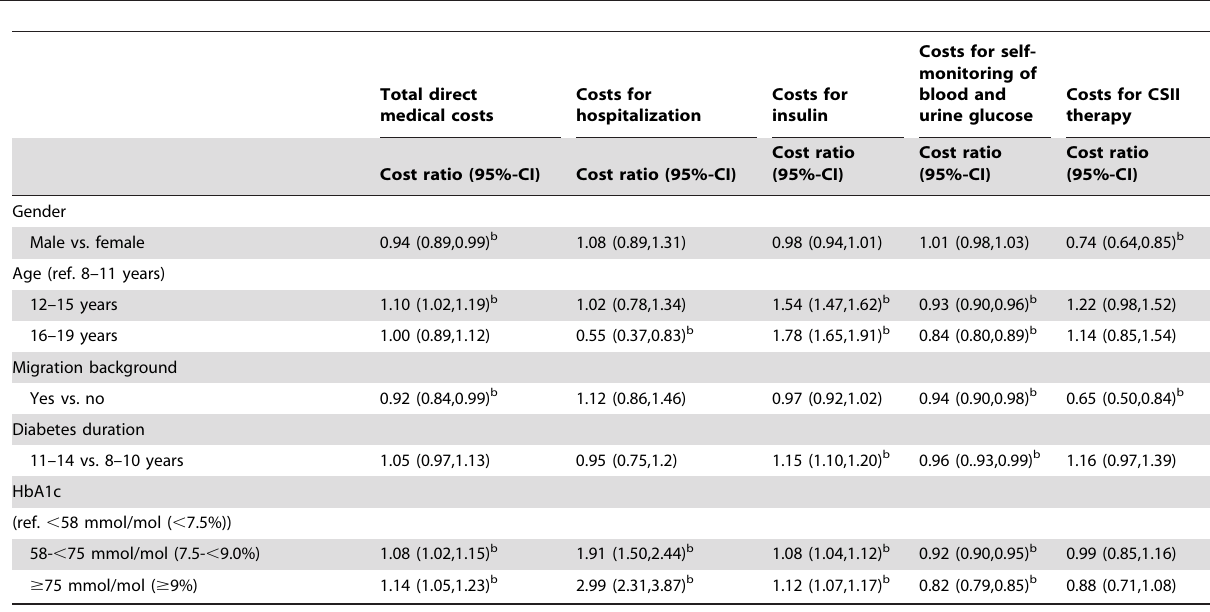
Table 5. Factors associated with total direct medical costs and different cost categories per patient: Estimates of cost ratios a